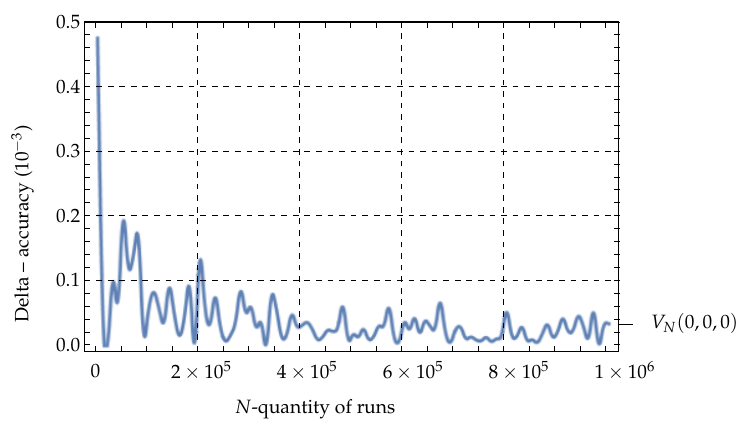
Table 1. Results for Problem ?? (in Example ?? )